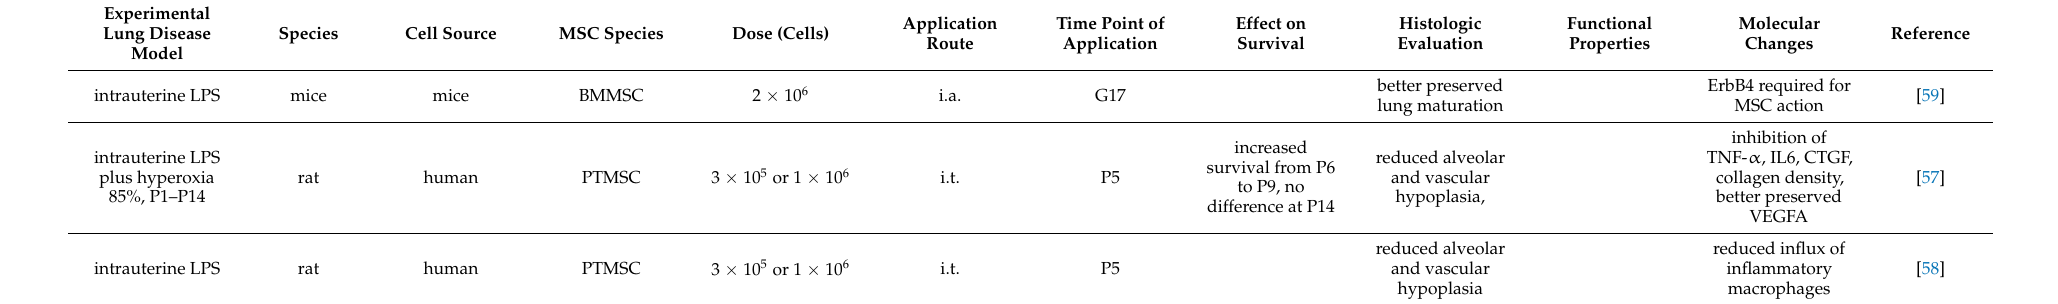
Table 3. Therapeutic actions of MSC to prevent or treat BPD in the LPS-induced rodent model.